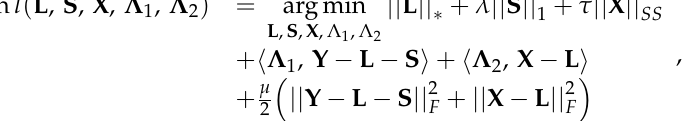
x ); and ( b ) weights superimposed on w ( 0 ); and ( b ) weights superimposed on d w ij ij ij